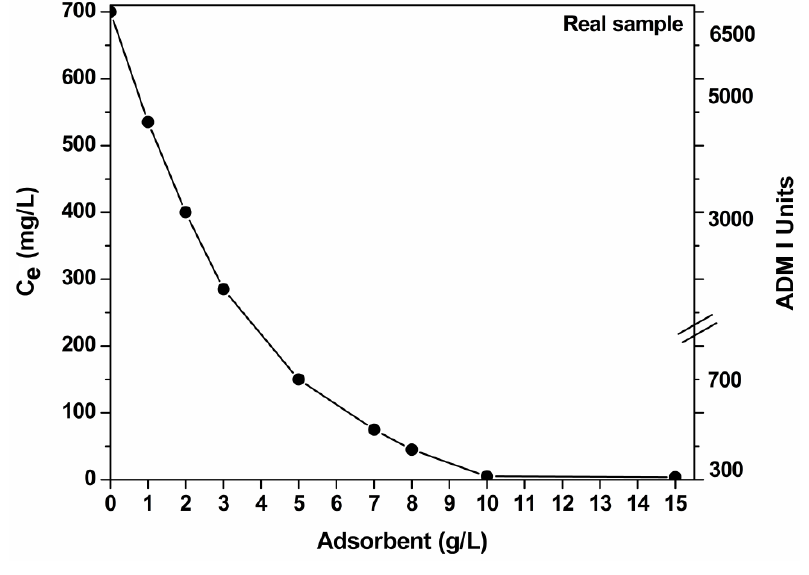
Figure 7. Effect of mass of adsorbent (COF) on decolorization of real textile effluents (pH = free, 700 mg/L total dye concentration; 1 g/L adsorbent; T = 25 °C; 60–140 rpm; 24 h